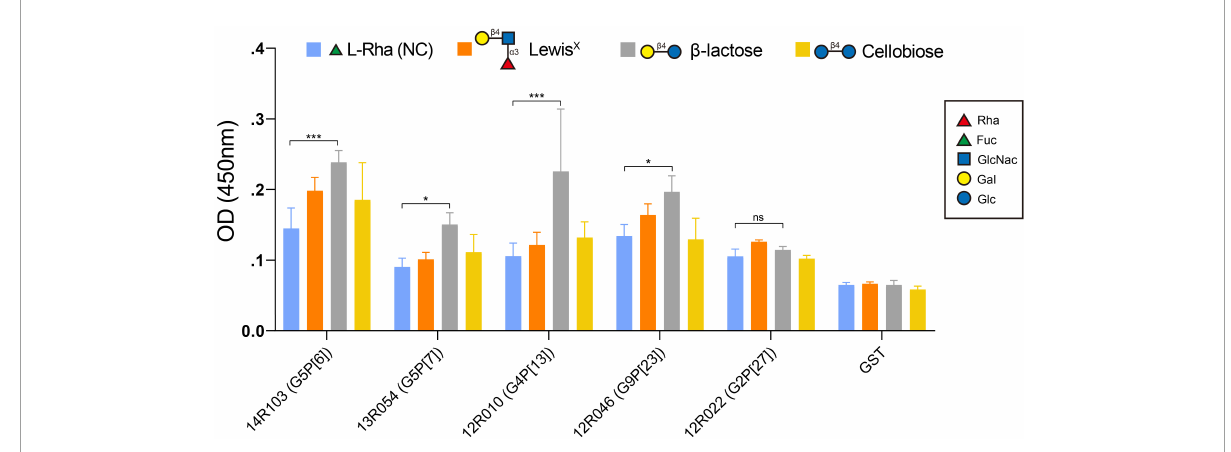
FIGURE5 Binding of the recombinant VP8 ∗ proteins from the RVA strains 14R103 (G5P[6]), 13R054 (G5P[7]), 12R010 (G4P[13]), 12R046 (G9P[23]) and 12R022 (G2P[27]) to synthetic oligosaccharides. Polyacrylamide (PAA)-biotin conjugates of Lewis X , β -lactose, cellobiose and L-Rha [negative control [NC)] were used in the binding assay. The GST-VP8 ∗ fusion proteins from RVAs 14R103 (G5P[6]), 13R054 (G5P[7]), 12R010 (G4P[13]), 12R046 (G9P[23]), and 12R022 (G2P[27]) were used in the binding assay to confirm the binding specificity. GST-tagged recombinant proteins and the GST tag alone were tested. Error bars in the panel represent the means ± the SD from triplicate experiments. ***, P < 0.001. *, P < 0.05. ns, P >